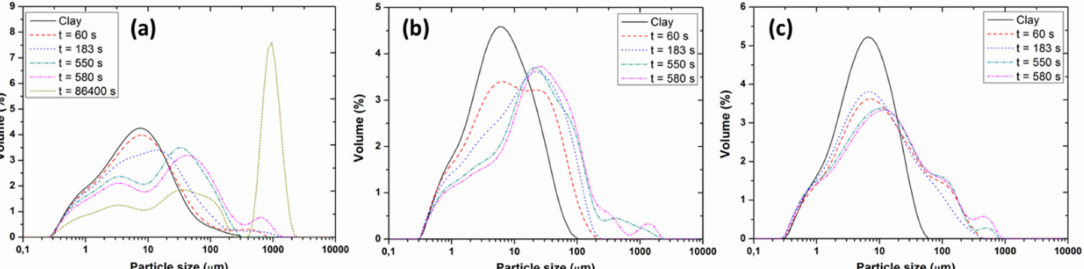
Figure 3. Particle size distribution for 0.7 g / L clay concentration with ( a ) 0.05 mg / g, ( b ) 0.25 mg / g and ( c ) 2.5 mg / g anionic flocculant. “Clay” represents the particle size distribution (PSD) of pure clay before addition of flocculant and t = 0 s corresponds to the time when the flocculant was